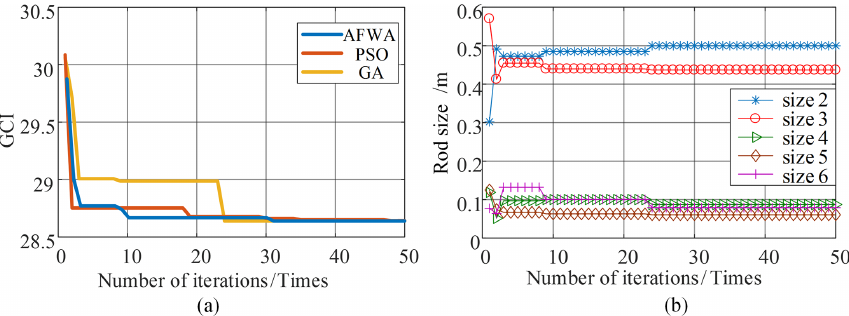
Figure 9. Particle evolution diagram with GCI as optimization target. (a) GCI index evolution diagram. (b) Particle evolution diagram for each link size.